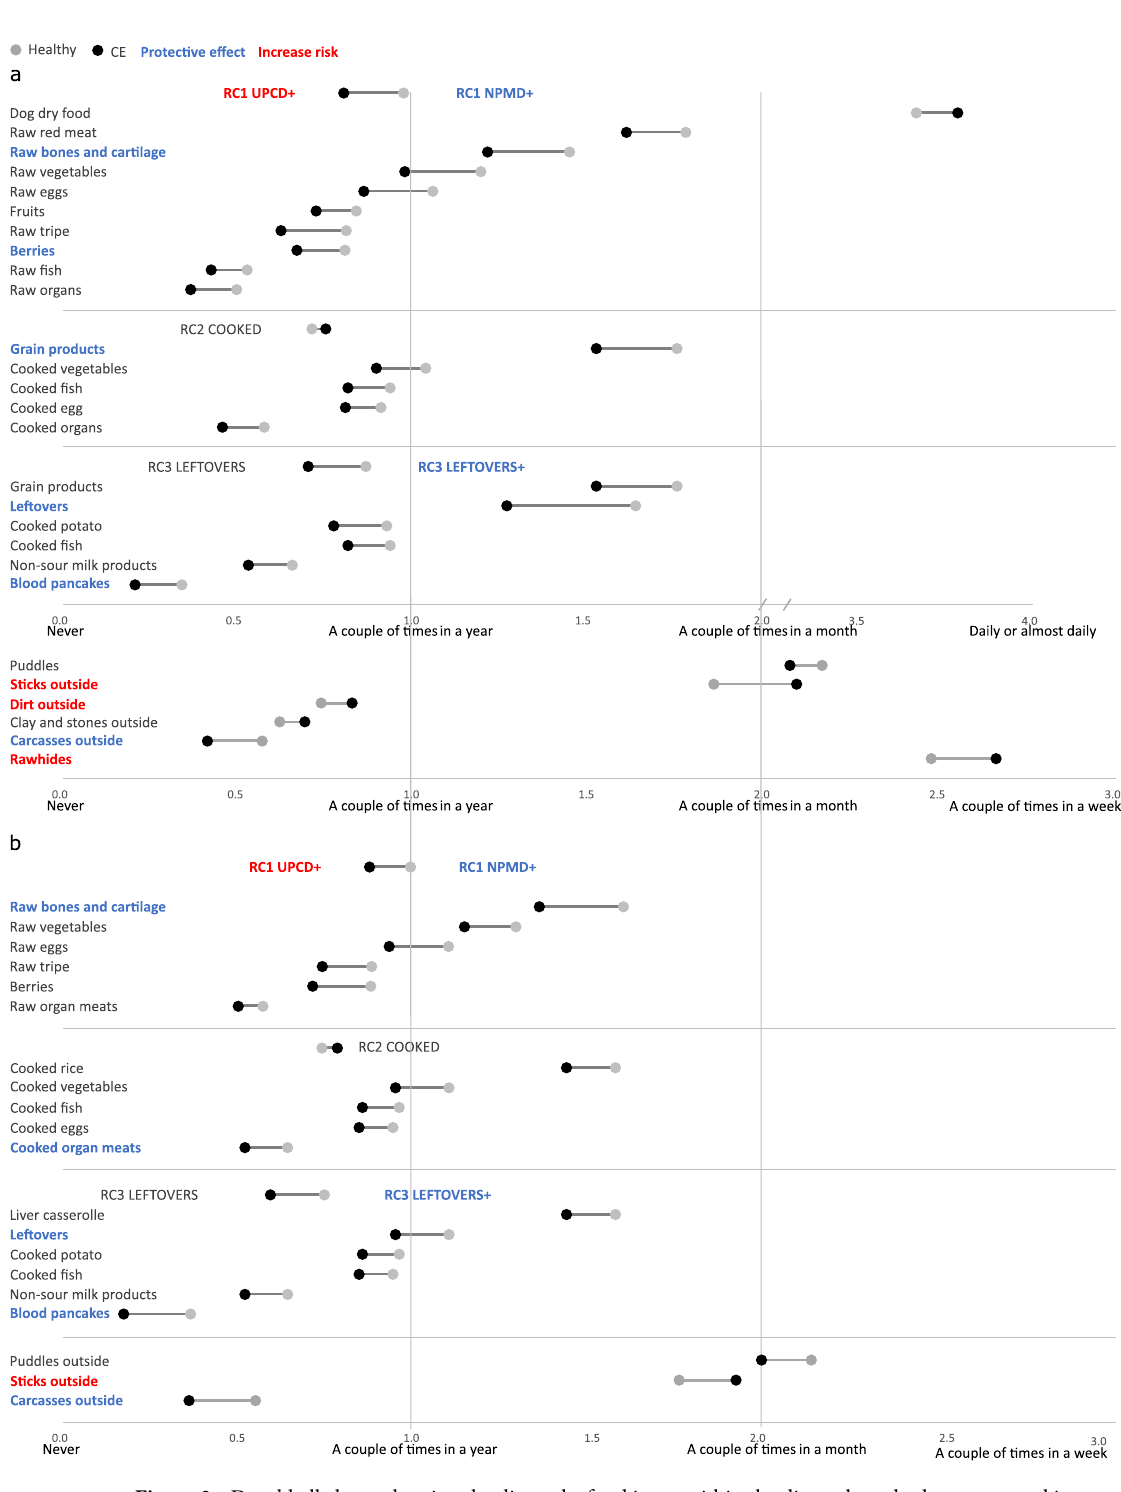
Figure 3. Dumbbell charts showing the diet style, food items within the diet style and other consumed items as mean feeding frequencies of control dogs (grey) and dogs with chronic enteropathy (CE; black) during a) puppyhood and b) adolescence. Only items that were significantly different ( p < 0.05) between controls and cases in the preliminary screen are included. Diet and food items that significantly ( p < 0.05) decreased the risk of CE later in life are highlighted as blue text. Diet and food items that significantly ( p < 0.05) increased the risk of CE later in life are highlighted as red text. Text color and circles color legends are shown on the top of the figure. Detailed analysis results are shown in Table 3. Range values are shown in Supplementary information 3. NPMD = non-processed meat-based diet, UPCD = ultra-processed carbohydrate-based diet, COOKED = Home cooked diet, LEFTOVERS = Human meal leftovers and table